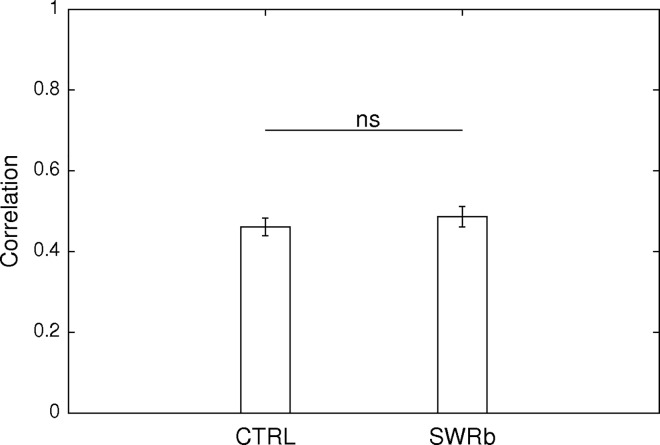
Stability at the population level.Cofiring similarity based on the joint firing of cell pairs between the first and the second exploration of the same environment on control days (1649 cell pairs, left bar) and SWR-blockade days (1176 cell pairs, right bar). The difference does not attain the threshold for significance (Z = -0.749; p = 0.454, Fisher’s Z-test).